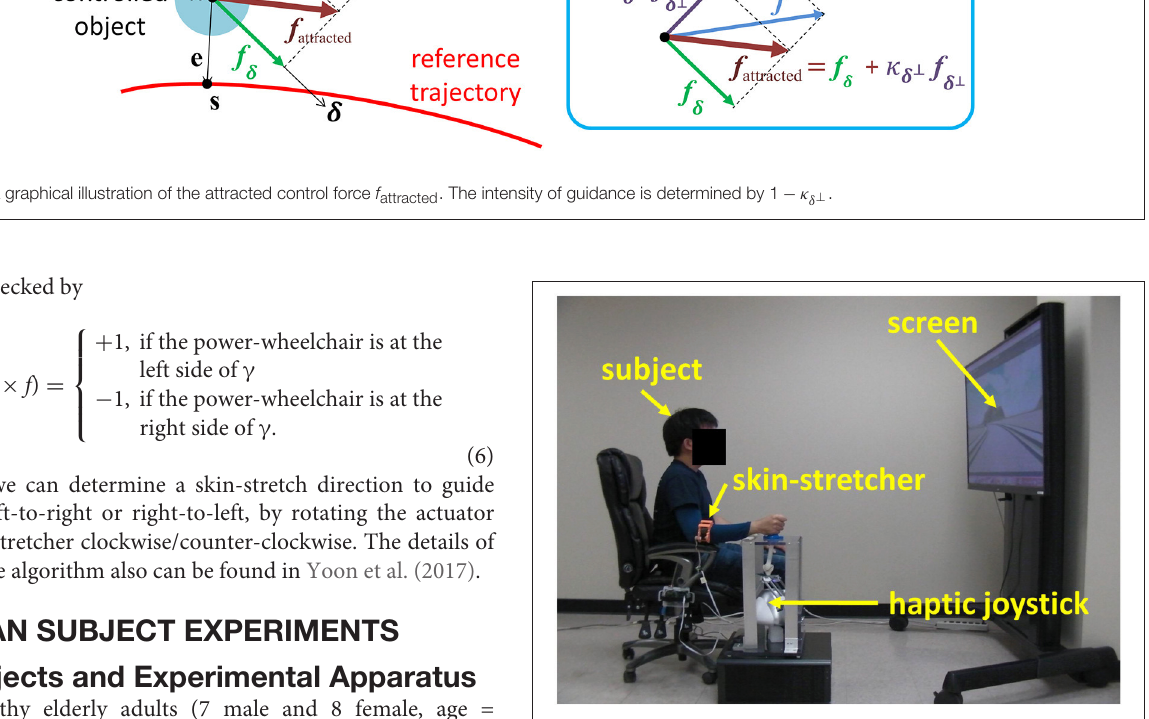
(smooth left turn with a rock on the road), Task2 (smooth right turn with a horse on the road), Task3 (sharp right turn with a cart on the road), and Task4 (sharp left turn with trash cans on the road). In each scenario, subjects were exposed to a road with different curvatures at the point where an obstacle was placed. Subjects were instructed to pass the obstacle and reach the goal position (marked as a white finish line on the road) as fast and safe as they could without colliding to the obstacle or the road boundaries. During the evaluation session, the augmented sensory feedback for guidance was provided based on four conditions: NA (no feedback augmentation), F (force feedback augmentation by the haptic joystick), C (cutaneous skin stretch feedback augmentation by the skin-stretcher), FC (force feedback and cutaneous skin stretch feedback augmentations by both devices). Each task trial was presented with a random combination of the four task scenarios and the four sensory feedback augmentation conditions. Each trial was repeated three times; therefore, there were 4 (task scenarios) × 4 (augmented sensory feedback conditions) × 3 (repetition) = 48 total